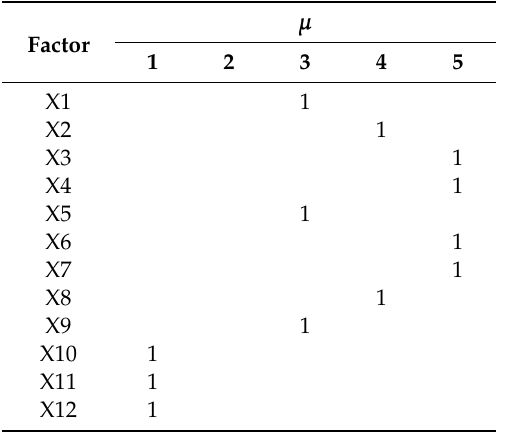
Table 4. µ -matrix for ABC in